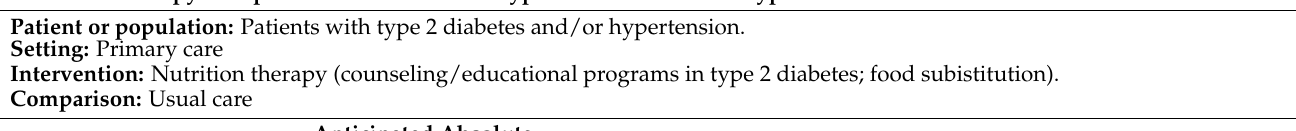
Table 1. Summary of findings and quality of the